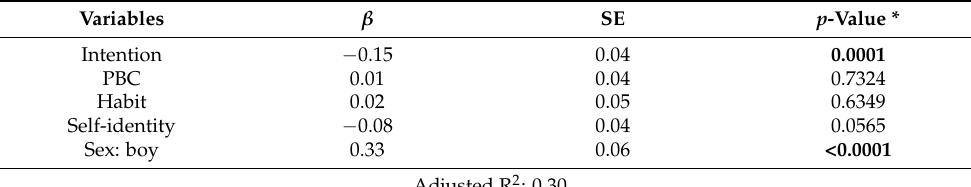
Table 3. Correlates of adolescents’ recreational screen time.